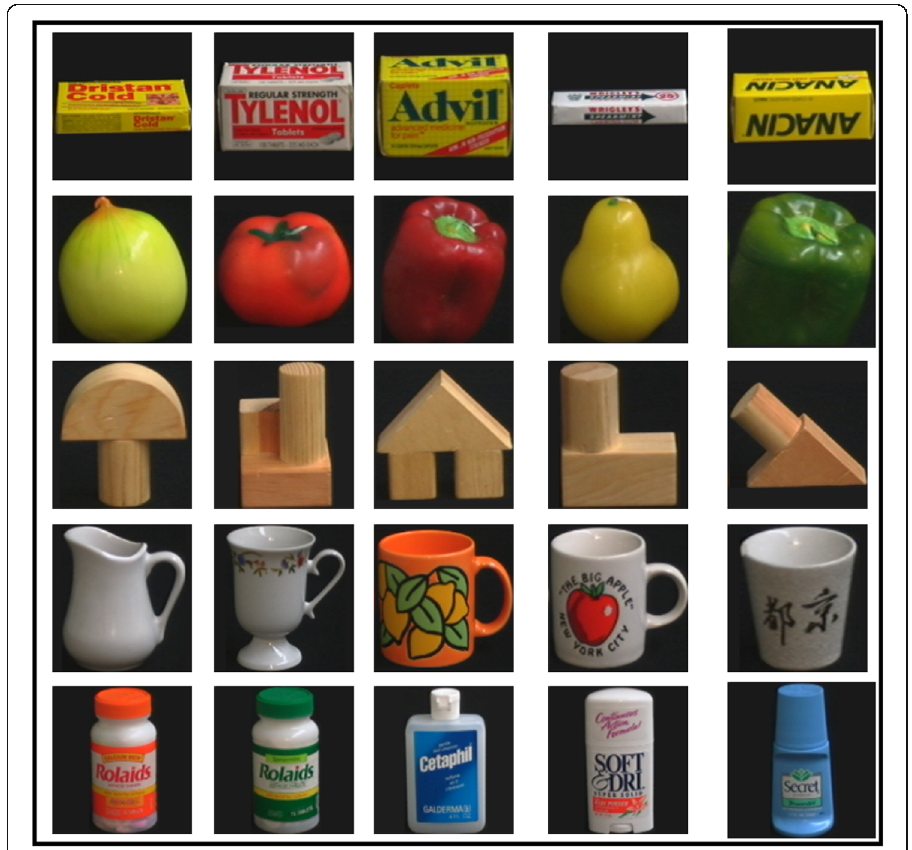
Fig. 10 Some typical color images in the Coil-100 dataset of Columbia